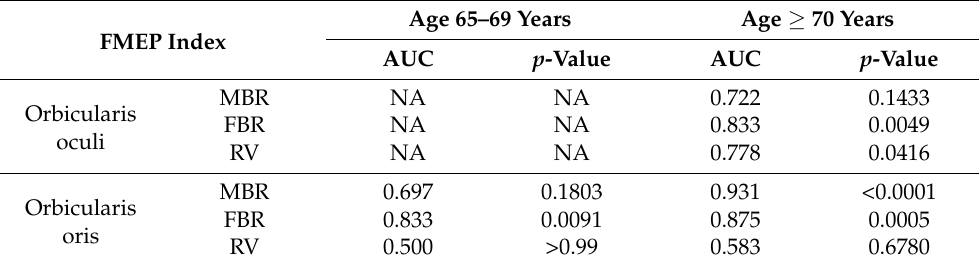
post-operative FN function in the two age